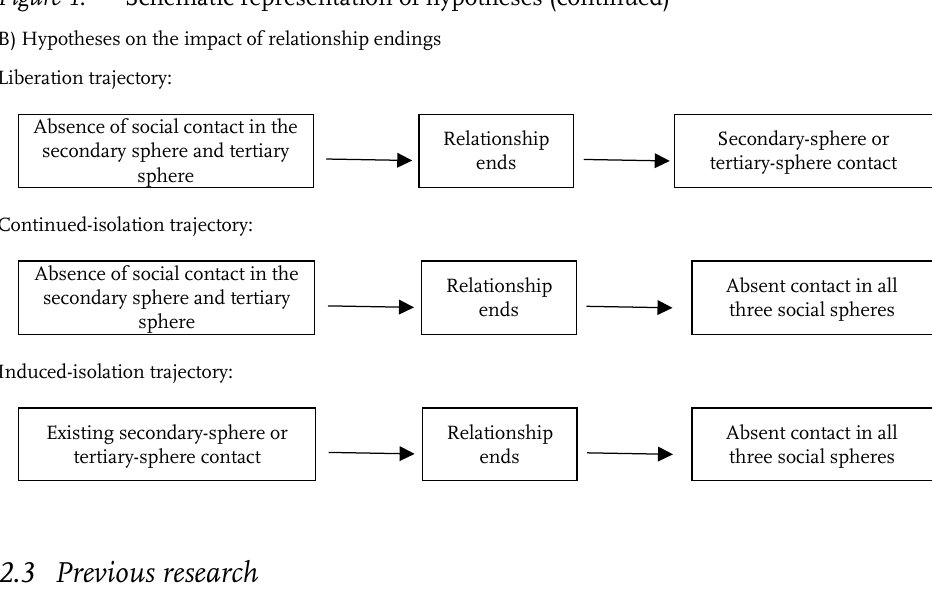
Figure 1 : Schematic representation of hypotheses